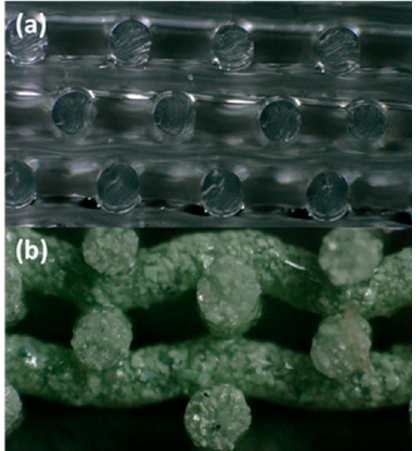
Figure 4. Side views comparing deviations in printed ( a ) SiO 2 and ( b ) WO 3 samples.